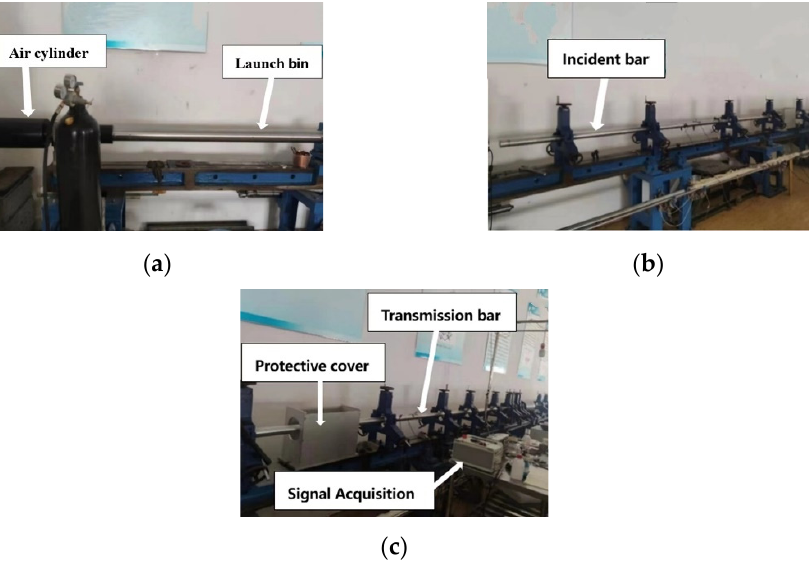
Figure 3. SHPB setup used in current test study. ( a ) Air cylinder and launch bin; ( b ) Incident bar; ( c ) Transmission bar, protective cover and signal acquisition.